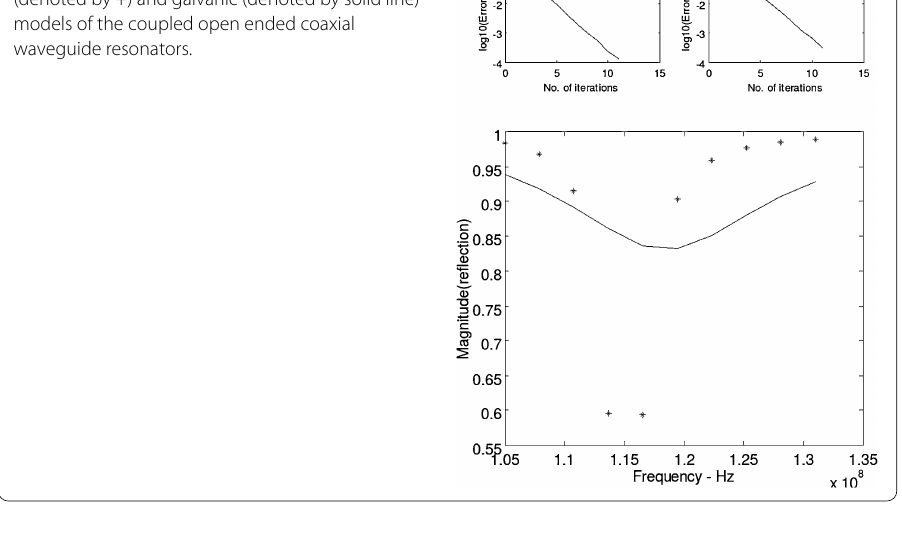
Figure 6 Results of numerical simulations for exact values of parameters s true = 10 –4 , h true = 1 mm, R true = 10 –3 , R true = 0.1. Top figures DGR WLR show error plots for four reconstructed parameters: stars denote errors for the model with using the open ended quarter resonator pair, and solid lines denote errors for the model without using the open ended quarter wave resonator. Bottom figure presents magnitude of reflections for capacitive (denoted by +) and galvanic (denoted by solid line) models of the coupled open ended coaxial waveguide resonators.